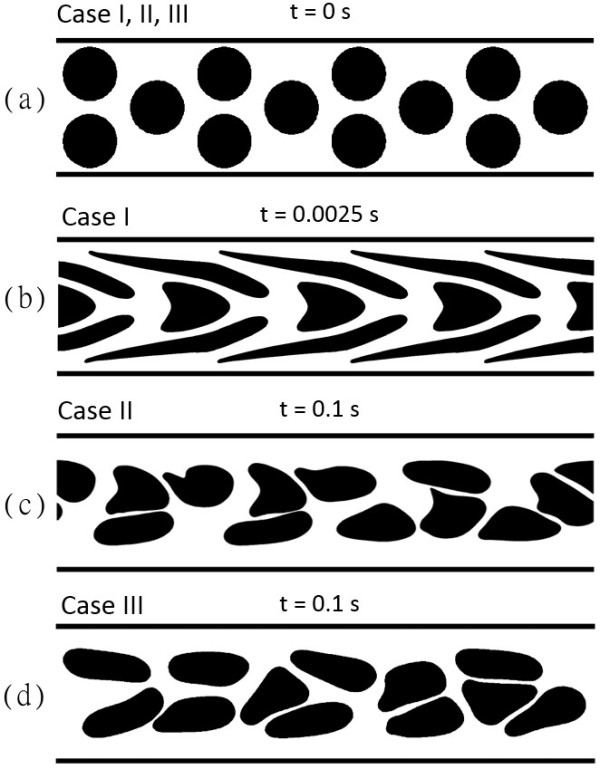
Instantaneous snapshots of the RBC deformation profiles for the three cases under the highest pseudoshear rate of 500 s-1. (a) Initial arrangement of RBCs for all three cases. (b) Simulated result from Case I. This case presents pronounced RBC stretching under the high shear condition whereby cells near the wall undergo “noodle-like” transformations. It should be noted that the simulation failed at t = 0.0025 s due to the non-physiological deformation of RBCs near the channel wall. (c) and (d) Simulated results from Case II and Case III. Case II exhibits higher incidences of “pinched” RBCs with sharp-edged profiles than those of Case III, thus demonstrating the effect of the bending treatment for large deformation applied in Case III but absent in Case II.